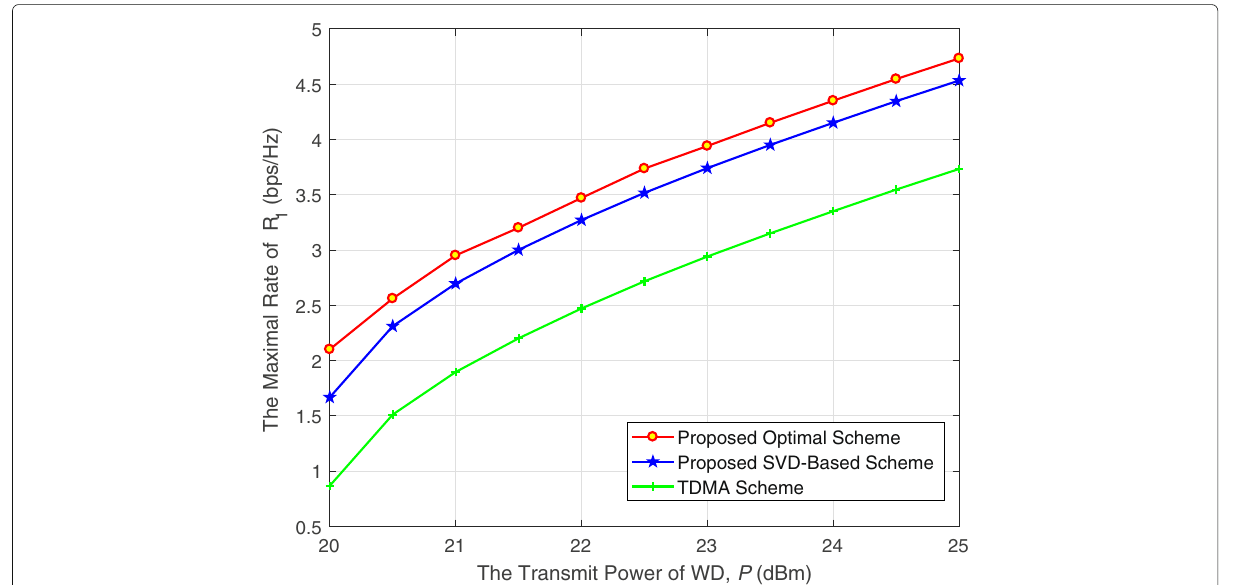
Fig. 2 Simulation 1. The maximal rate of R 1 versus the transmit power at WD for different schemes with N = 4 and R M = 4 bps / Hz